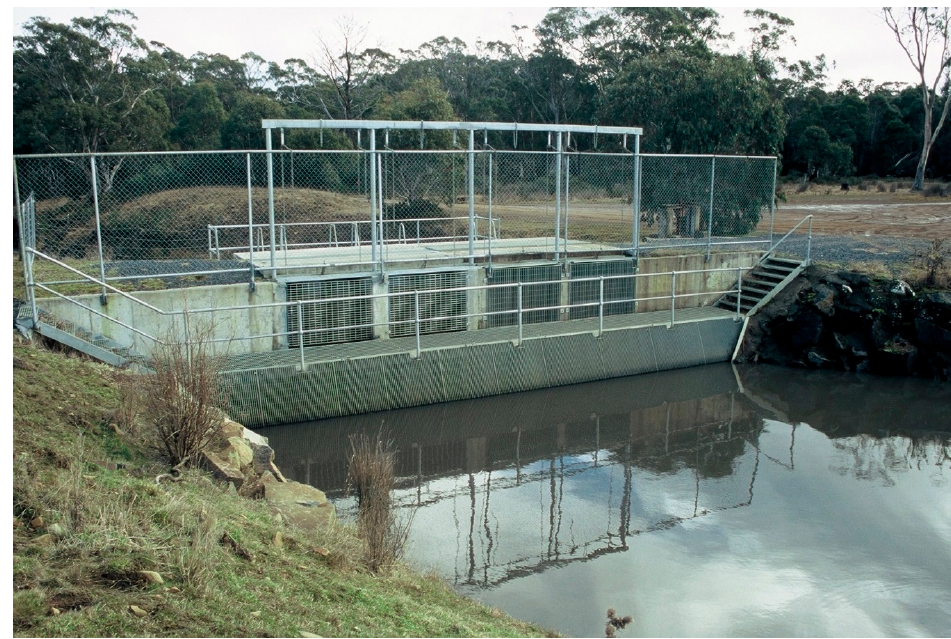
Figure 2. The Lake Crescent outlet structure showing the coarse external screens.